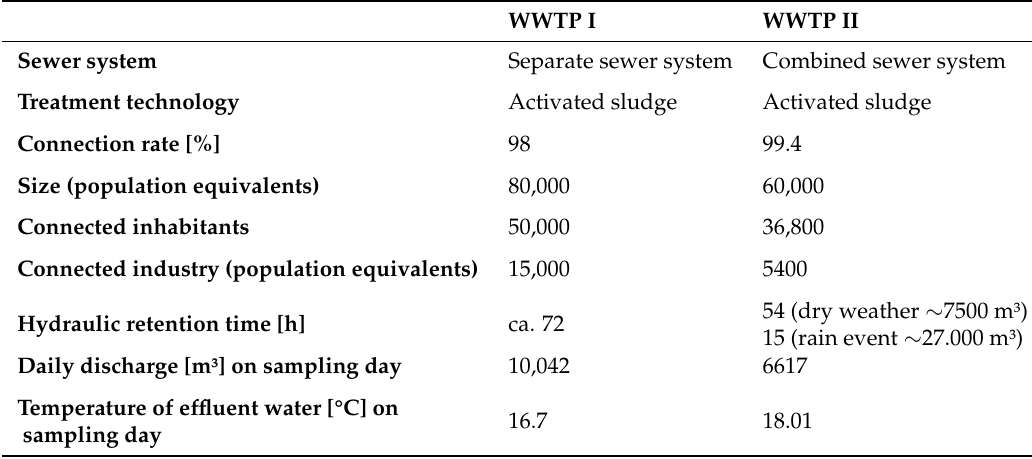
Table A1. WWTP Information of the Holtemme River.